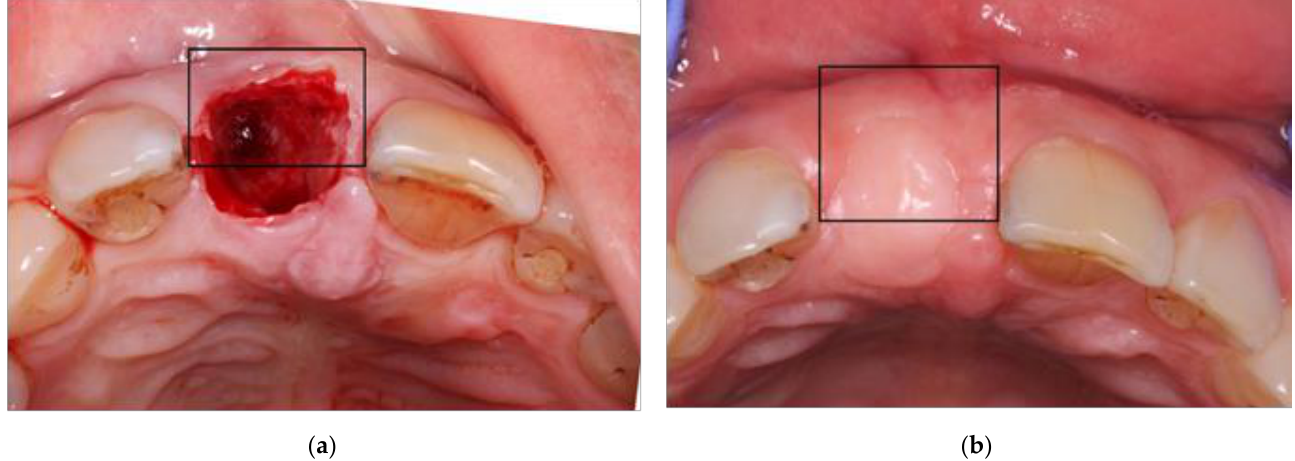
Figure 1. T0 ( a ) and T6 ( b ) images with a superimposed vertical rectangle which borders the most buccal edge of the edentulous gap.